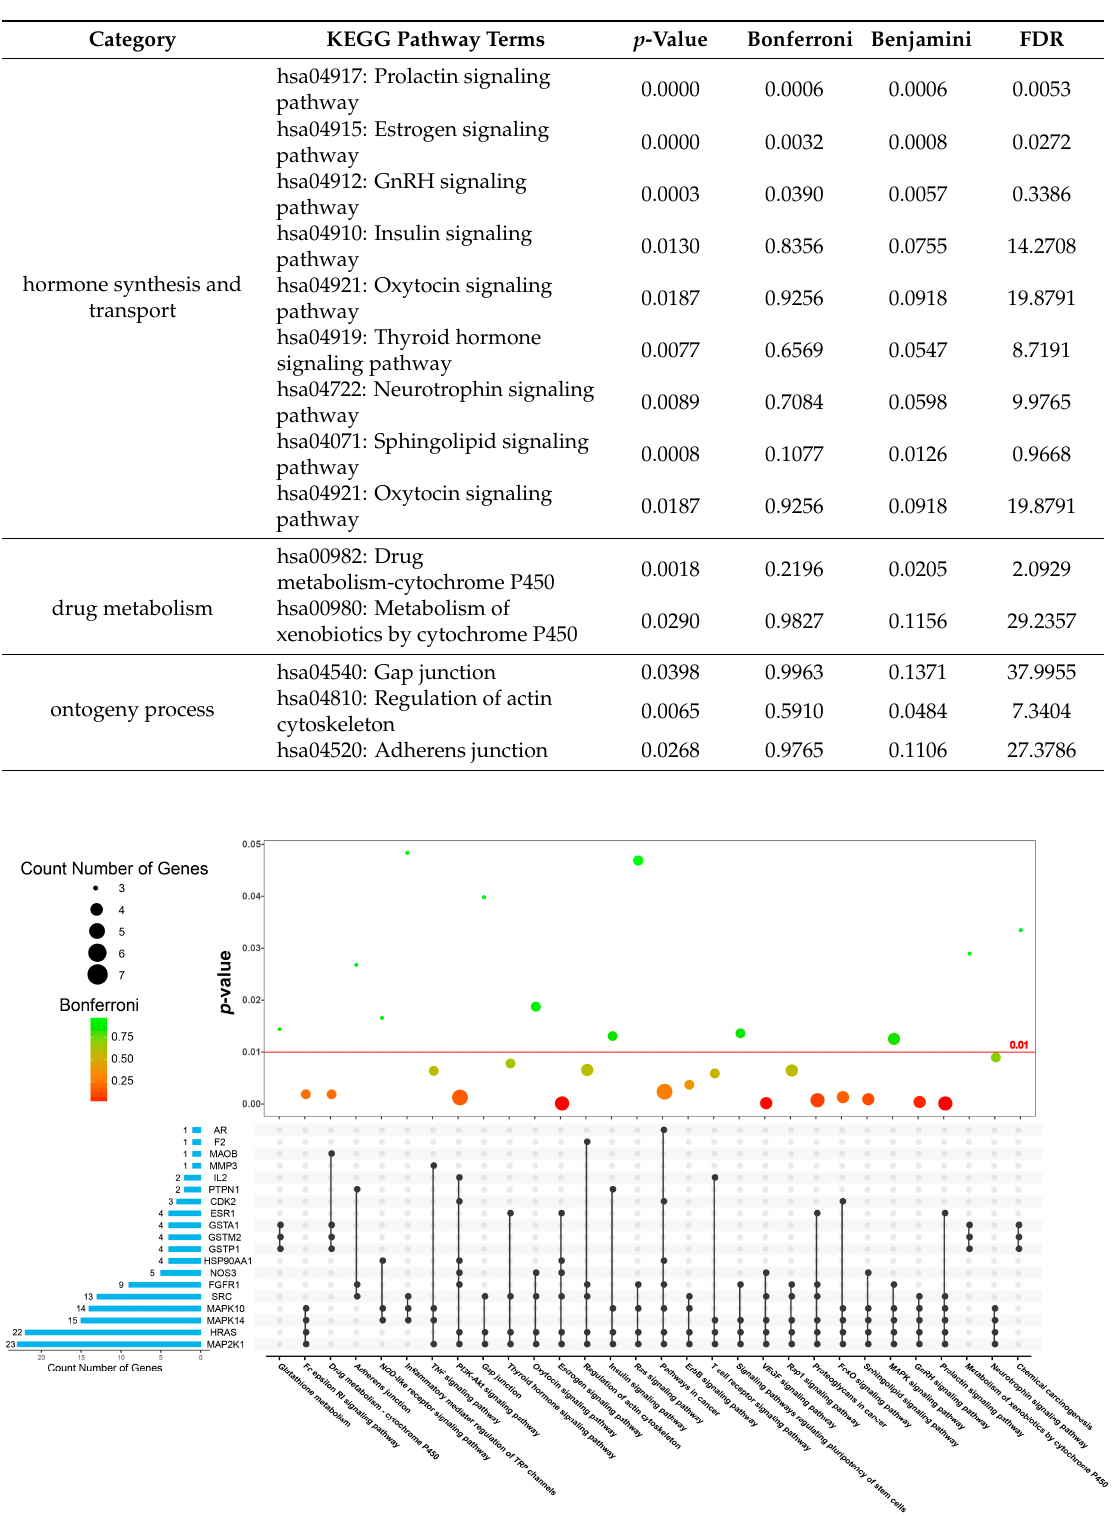
Figure 5. KEGG pathway enrichment bubble diagram for the top 30 putative target proteins ( p -value ≤ 0.05).